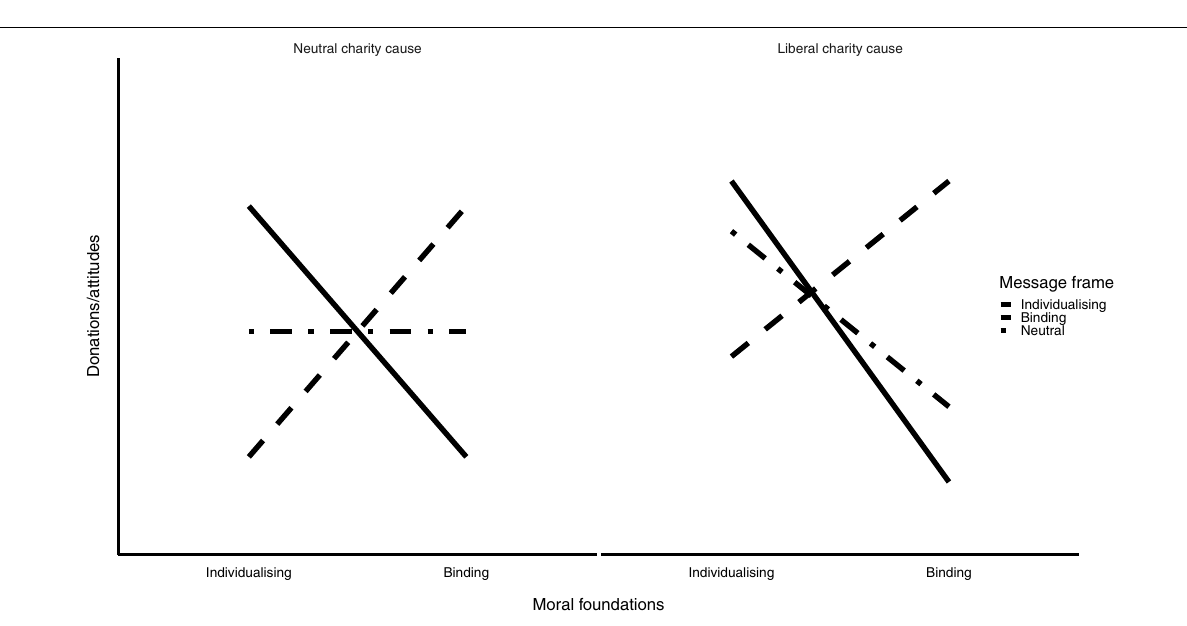
FIGURE 4 | The expected effects of individualizing, neutral and binding calls-to-action on donating attitudes and CB, with respect to participants’ scores on